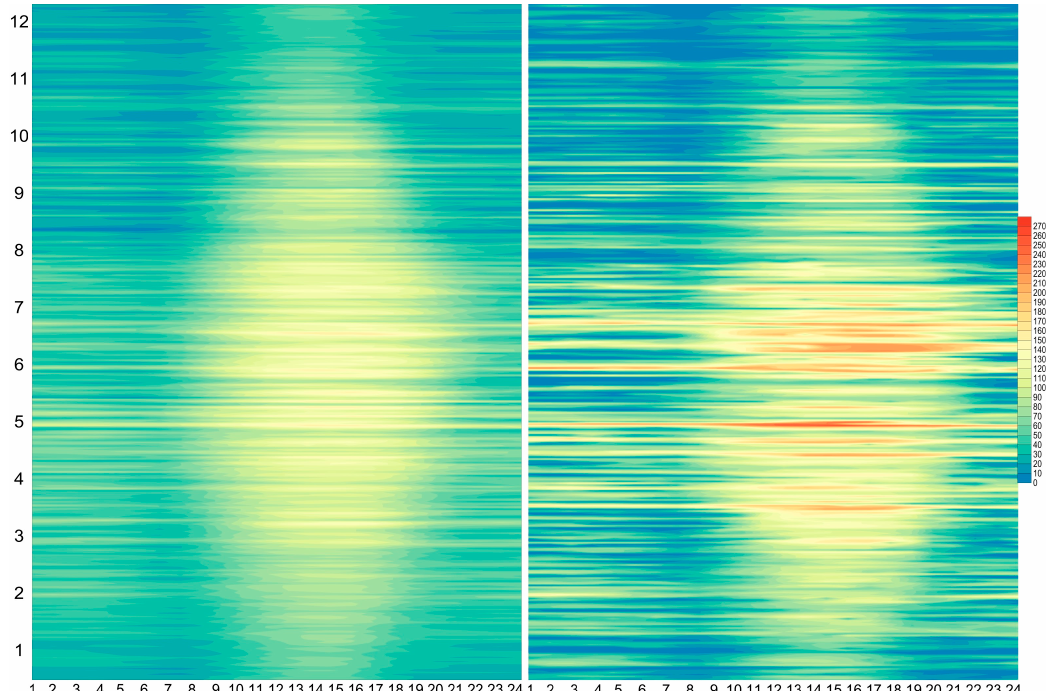
Figure 6. Average hourly stacked graph of O 3 concentration for five years during 2013–2017 (Left) and for the specific year of 2015 (Right).